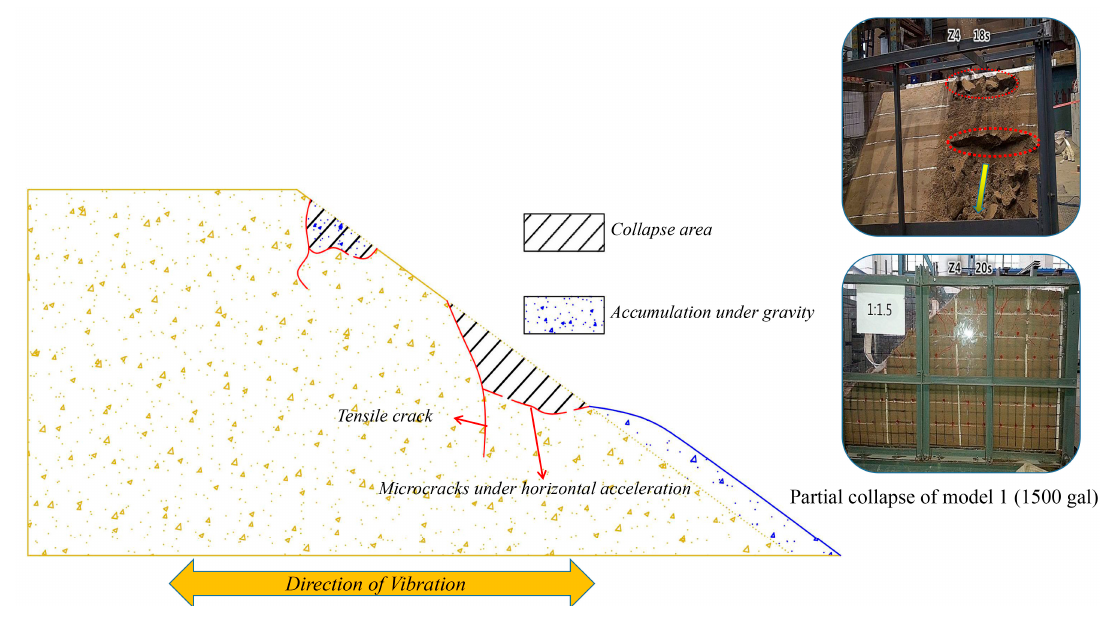
Figure 14. Partial collapse of model 1.